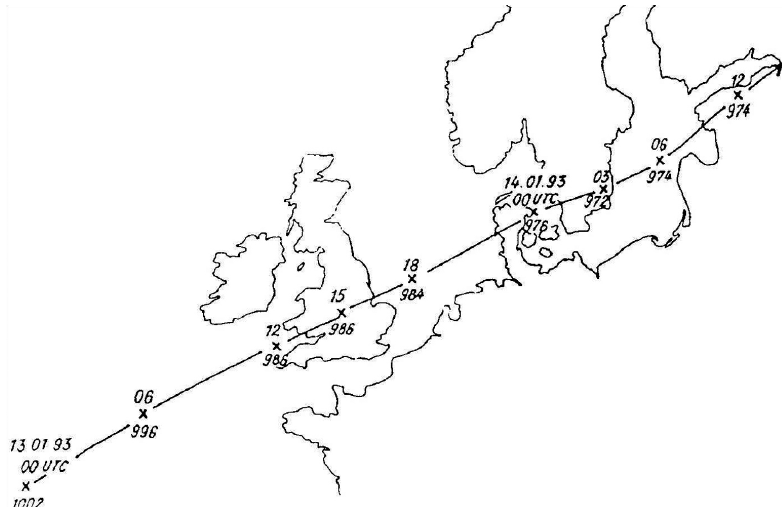
Fig. 4. The route of centre of storm low-pressure system hPa for the period 13th of January, 00 UTC to 14th of January, 12 UTC, 1993 (Wiśniewski